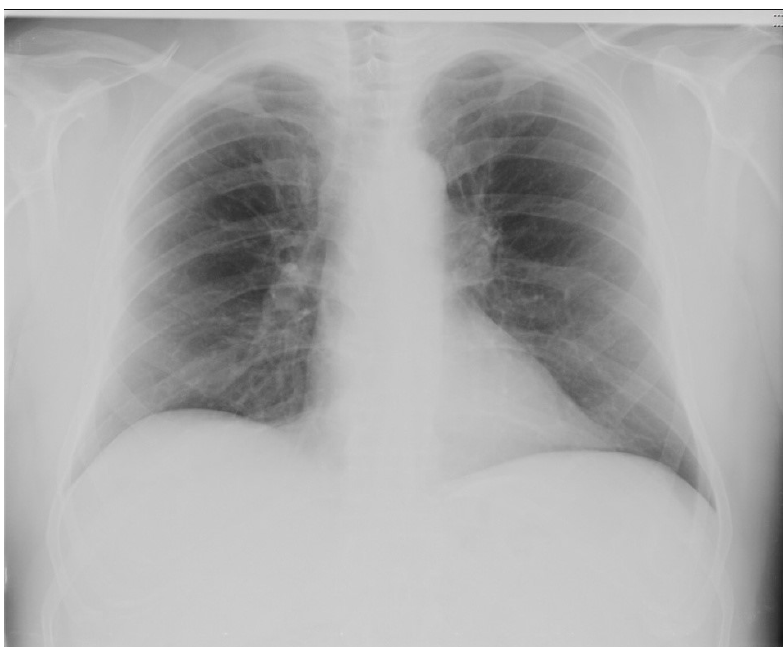
Figure 2. Chest X-Ray in SARS-CoV-2. Chest X-Ray displays a typical bilateral ground glass pattern, which tends to affect the posterior segments of lower lobes, with a peripheral and sub-pleural